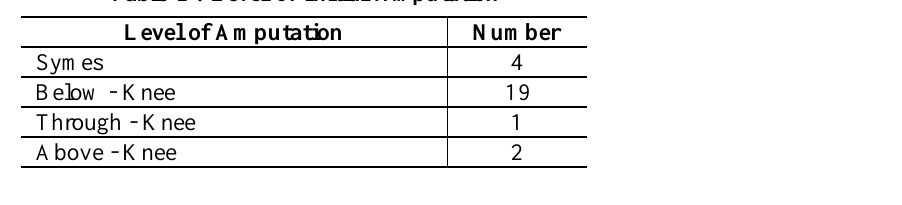
Table II : Indication for Initial Amputation